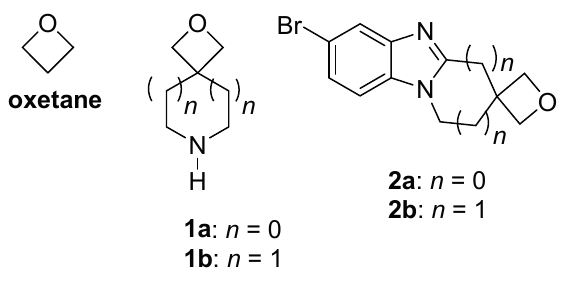
Figure 1. Rationale design of synthetic